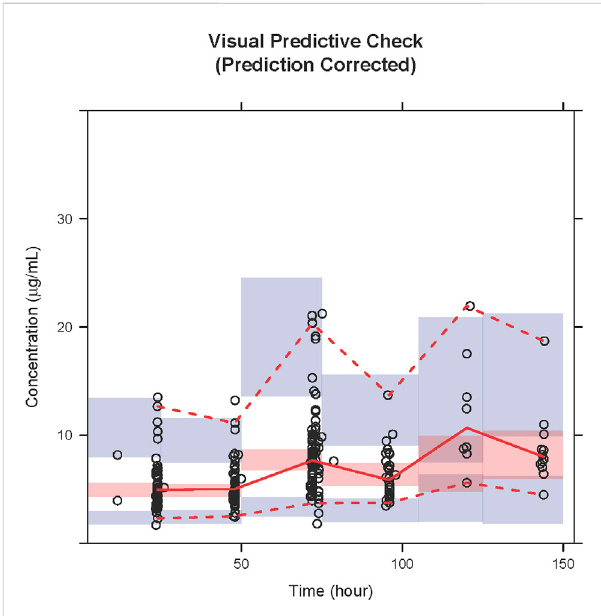
FIGURE 2 PcVPC results of the fi nal model. Open circles represent the observedconcentrations,andthesolidlineanddashedlinesrepresent the observations ’ median and 95% CI. The middle red shadow areas represent the 95% CI of medians, and the blue shadow areas represent the 95% CI of the 2.5th and 97.5th percentiles of the results of a 1,000 simulation in the fi nal